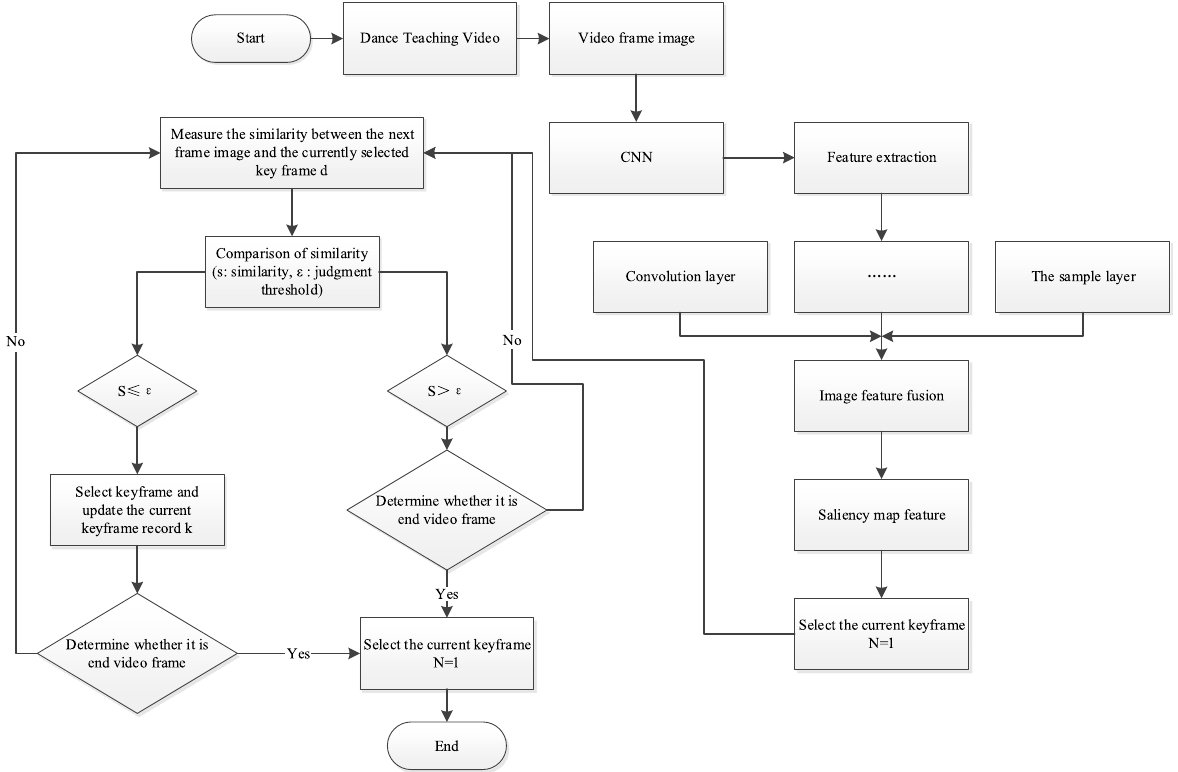
Fig. 2 Flow chart of the key frame extraction algorithm based on convolutional neural